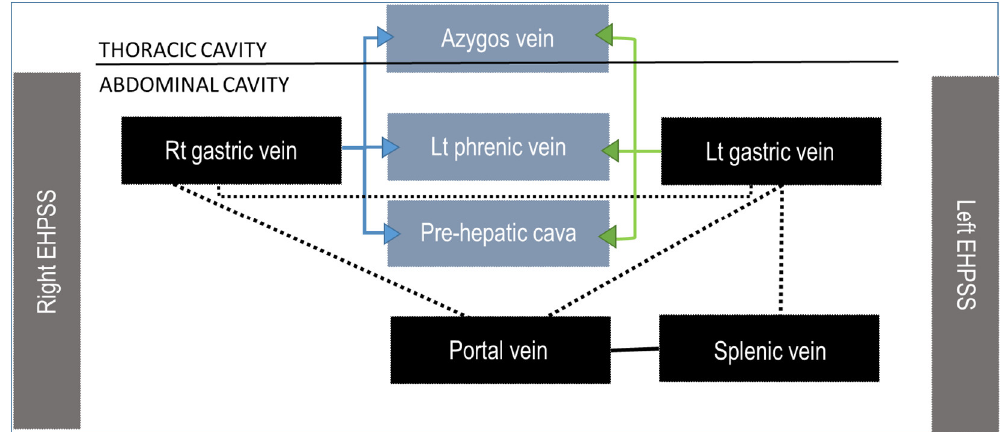
Figure 17. Most common patterns of side-to-side EHPSS reported in the veterinary literature. The black dotted lines represent the normal connections between the portal vein and its